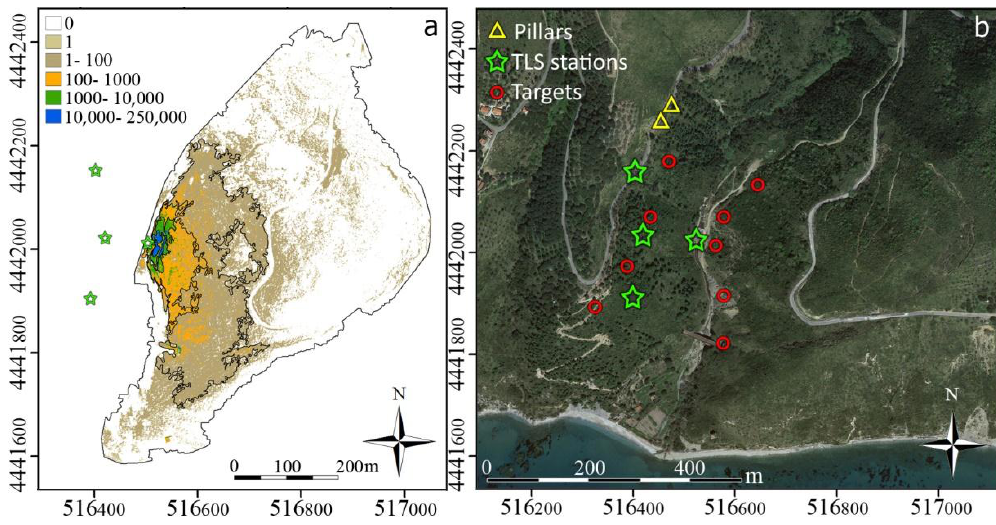
Figure 2. ( a ) Density distribution map. ( b ) Scheme of the TLS survey.